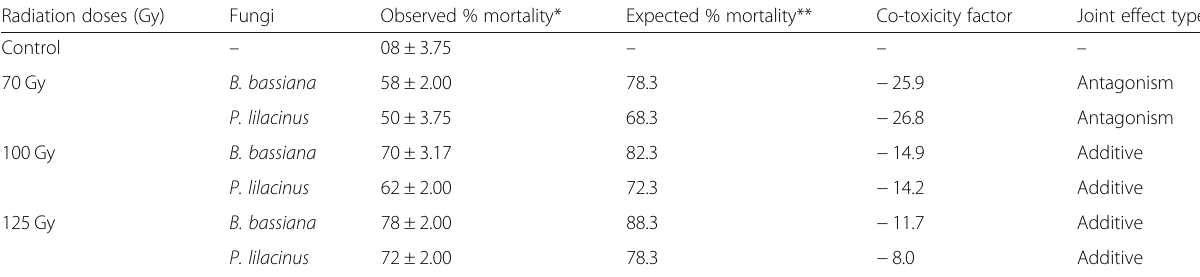
Table 4 Potency of interaction between of gamma irradiation and LC 50 of the entomopathogenic fungi, Beauveria bassiana and Paecilomyces lilacinu s against Galleria Mellonella larvae descending from the irradiated parental males Radiation doses (Gy)